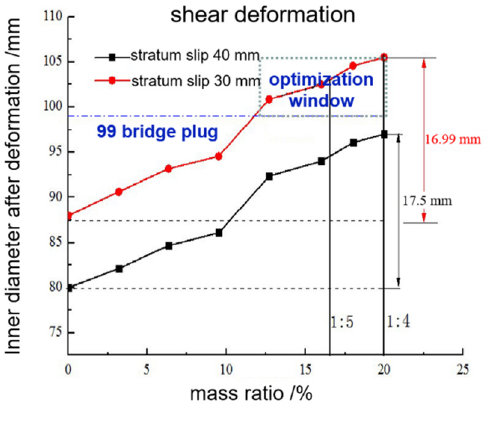
( c ) Figure 19. Modification results of cement sheath: ( a ) morphology of original hollow particles: “D1”, “D2”, “D3” are diameters of three particles; ( b ) particle crushing morphology; ( c ) casing defor- mation relief morphology. Under shear and extrusion conditions, the casing deformation transfer phenomenon is obvious under the action of modified cement sheath. The relationship between the inner drift diameter of casing and the mass ratio of hollow particles is shown in Figure 20. The local formation slip is 40 mm, for 125 ksi ( φ 139.7 × 12.7 mm) casing, when the mass ratio of hollow particles is 20%. Compared with the elastic cement without addition, the defor- mation absorbed under shear and extrusion conditions are 17.5 mm and 12.3 mm, respec-